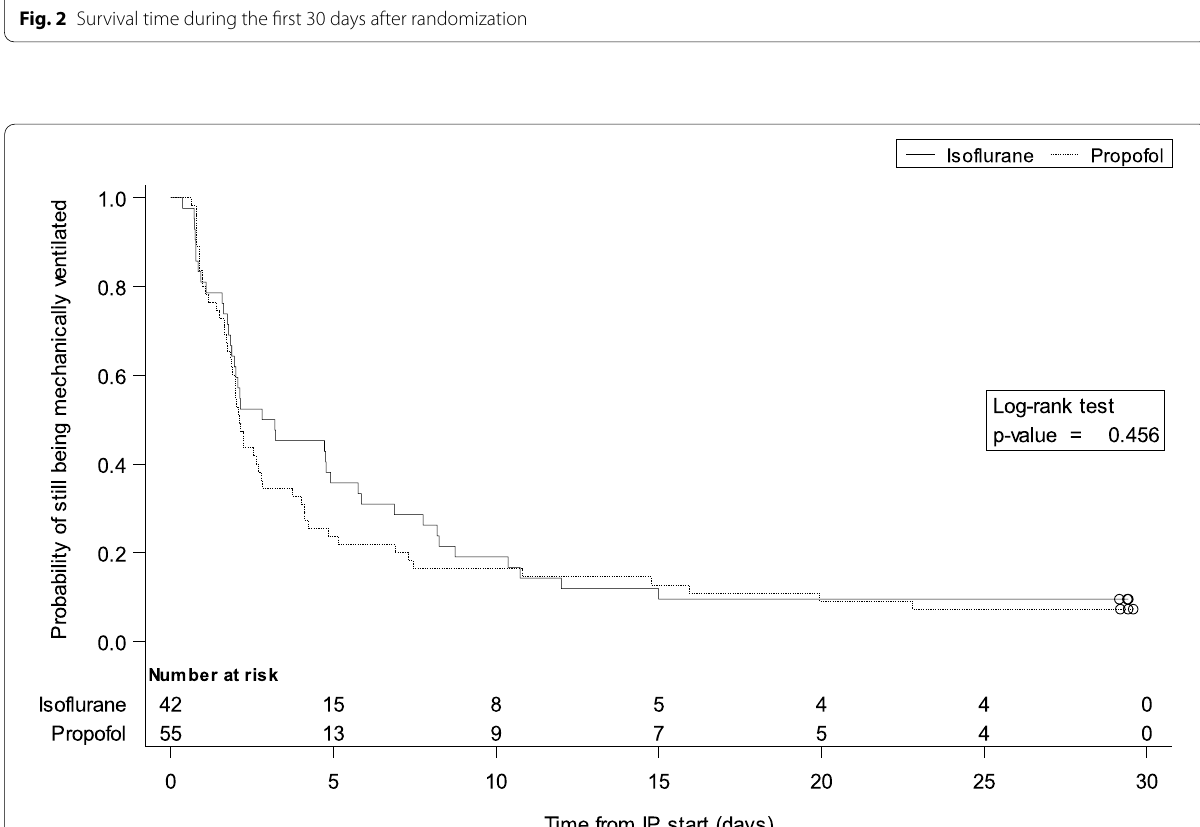
investigational =